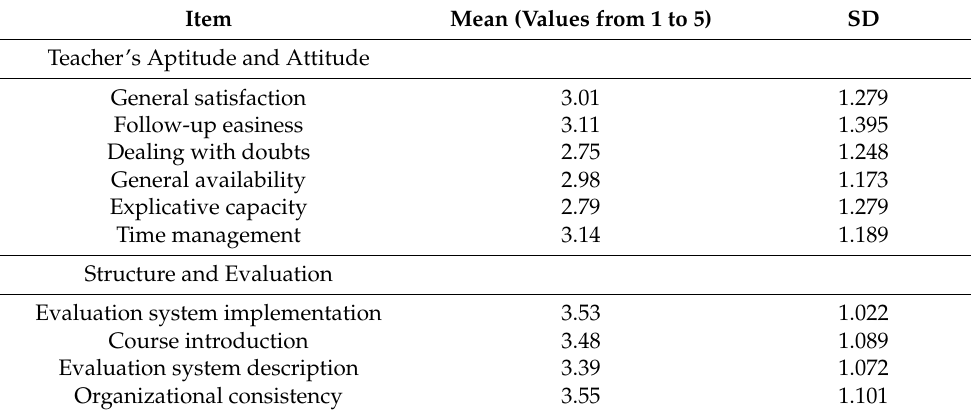
Table 6. Descriptive results obtained with the